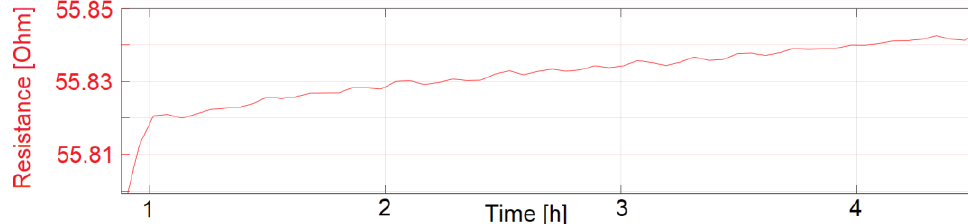
Figure 17. LCP 7 (without coating) start-up drift. Sensor signal drifts with ongoing exposure to 77.5 °C and 60% RH.